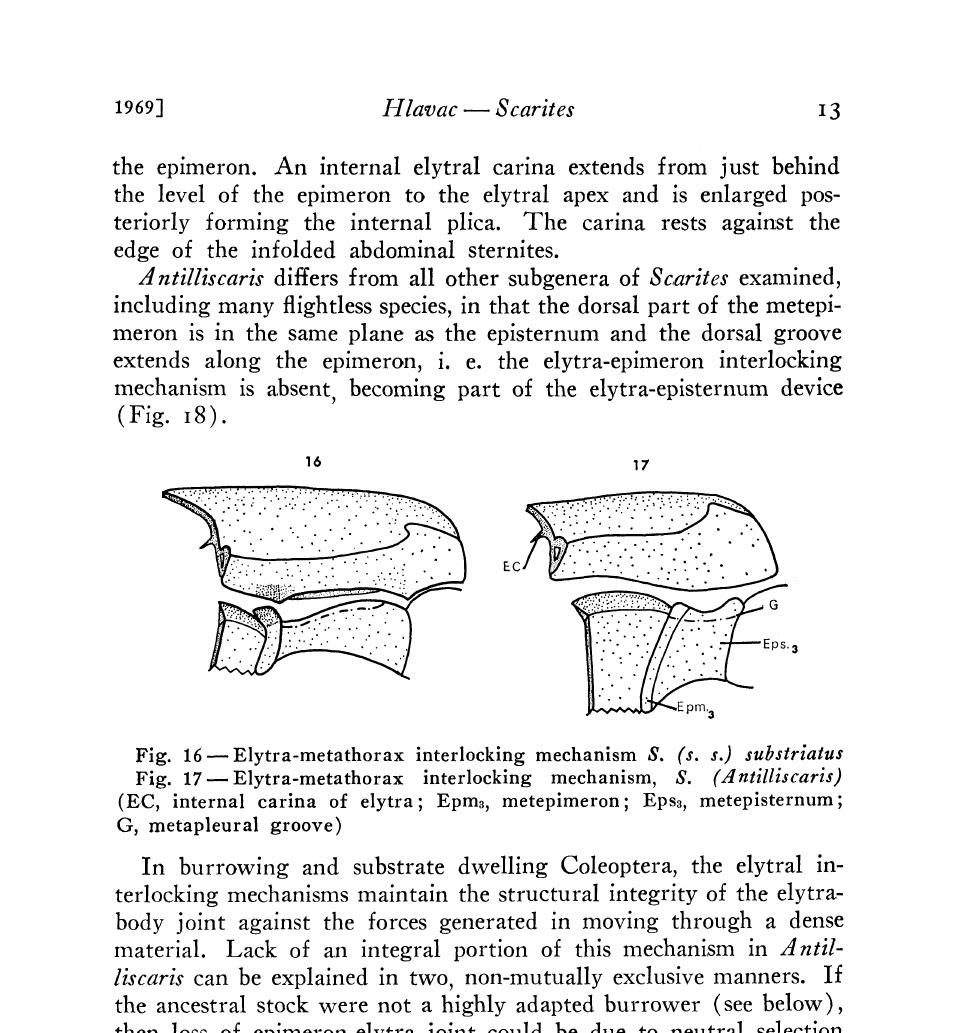
Fig. 16--Elytra-metathorax interlocking mechanism 8. (s. s.) substriatus Fig. 17---Elytra-metathorax interlocking mechanism, S. (Zlntilliscaris) (EC, internal carina of elytra; Epm3, metepimeron; Eps3, metepisternum; G, metapleural